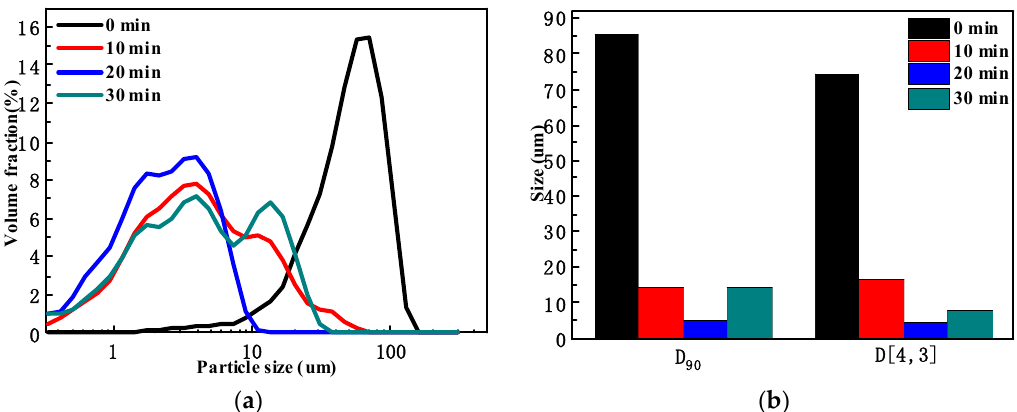
Figure 3. Effect of grinding time on coal particle size distribution. ( a ) Particle size distribution curves. ( b ) D90 and D[4,3] of the particles.